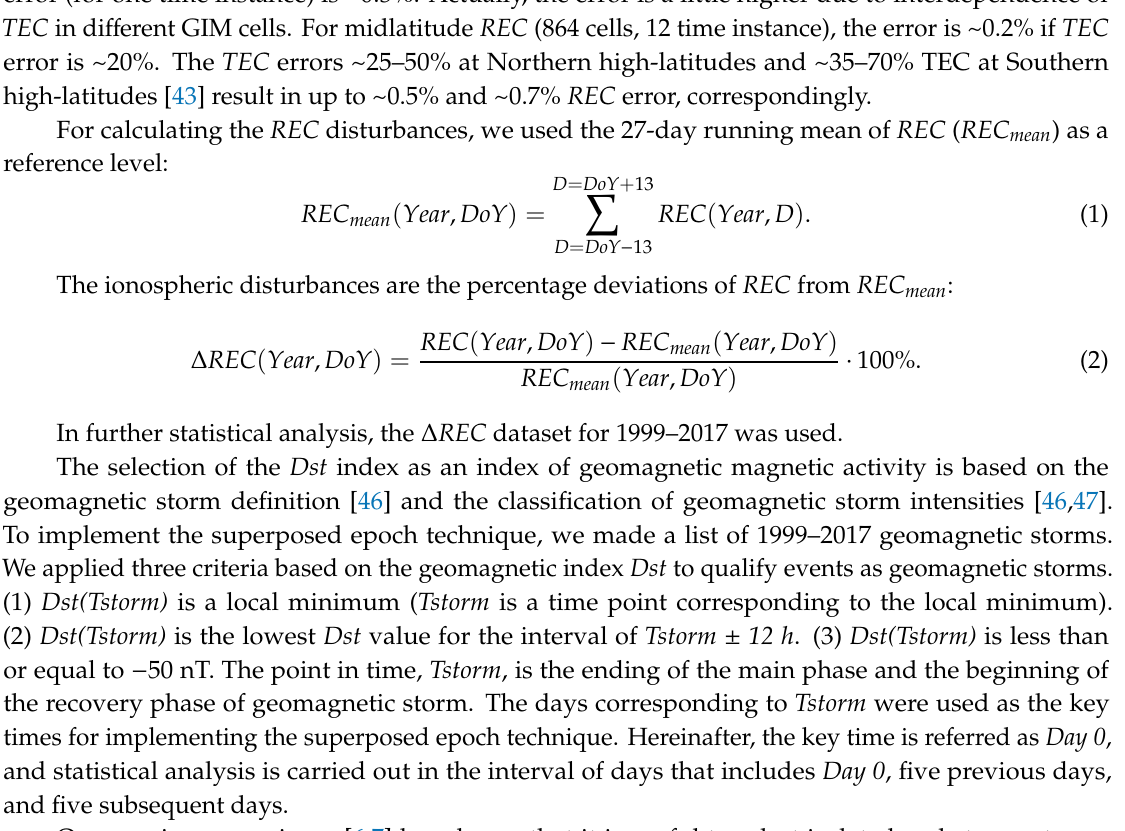
Table 1. Spatiotemporal ranges for regional electron content ( REC) calculation in corrected geomagnetic coordinates. Region Latitude Range Longitude Range UT Range Northern Hemisphere high-latitude zone 60 ÷ 90 ◦ 0 ÷ 360 ◦ 0 ÷ 24 Northern Hemisphere midlatitude zone 30 ÷ 60 ◦ 0 ÷ 360 ◦ 0 ÷ 24 Equatorial zone ± 30 ◦ 0 ÷ 360 ◦ 0 ÷ 24 Southern Hemisphere midlatitude zone − 30 ÷ − 60 ◦ Southern Hemisphere high-latitude